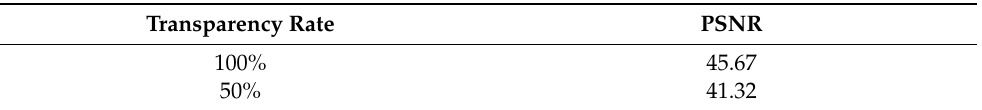
Table 2. PSNR (dB) results at different transparency rates of 100% and 50% with the IWRU-net for image watermark removal.